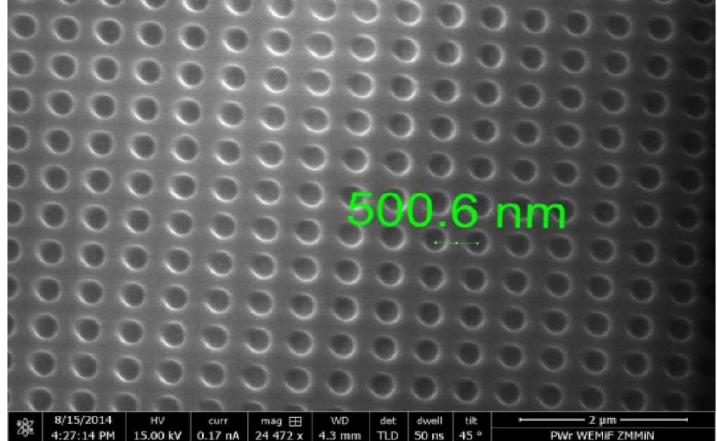
Figure 12. PhCs produced with focused ion-beam lithography, directly imprinted in the scintillator [55].